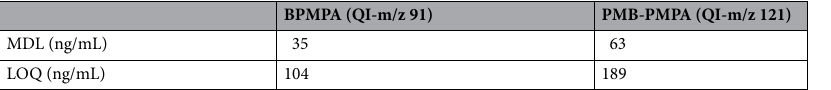
Table 1. MDL and LOQ values calculated for each derivatized PMPA analyte in the OPCW-PT soil sample. QI are the quantitation ions used in the calculation for each analyte.